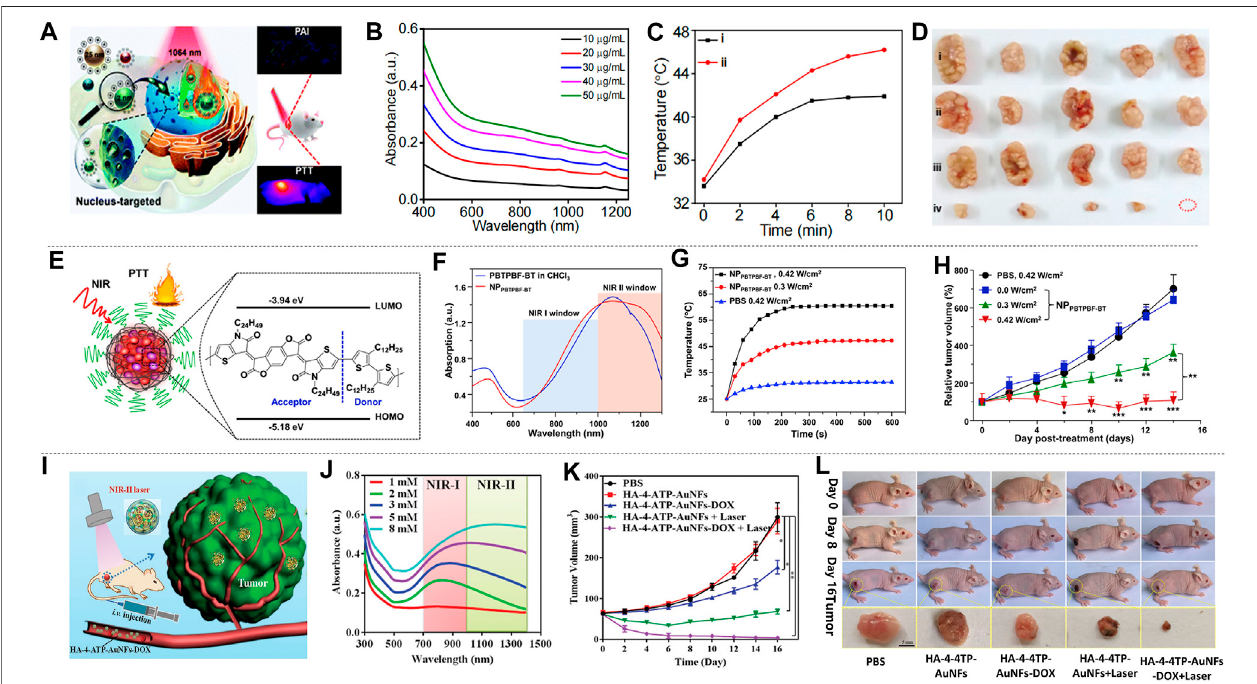
FIGURE8| TreatmenteffectofmicewithMCF-7andMDA-MB-231breastcancercells. (A) Graphofnucleus-targetingultrasmallCS-RuO 2 NPsandforPTTunder NIR- Ⅱ laser. (B) UV-vis-NIRabsorptionspectraofultrasmallCS-RuO 2 NPsatvaryingconcentrations. (C) Temperatureoftumorinlivemiceintwogroups:1)PBS+NIR- Ⅱ , 2) ultrasmall CS-RuO 2 NPs + laser. (D) Representative digital photos of tumor under four groups treatment: 1) PBS, 2) PBS + laser, 3) ultrasmall CS-RuO 2 NPs, 4) ultrasmallCS-RuO The MDA-MB-231 tumor growth curvesofdifferent groups ofmice (reproduced from (Caoet al., 2018) withpermissionfrom Elsevier BV). (I) HA-4-ATP-AuNFs-DOX for PTT. (J) UV – vis – NIR spectra of AuNFs with various HAuCl 4 concentration. (K) The tumor volume changes of fi ve groups ’ treatment. (L) Photos of mice in fi ve groups during three treatment period and tumor photo after treatment (reproduced from (Wang et al., 2020) with permission from Wiley-VCH